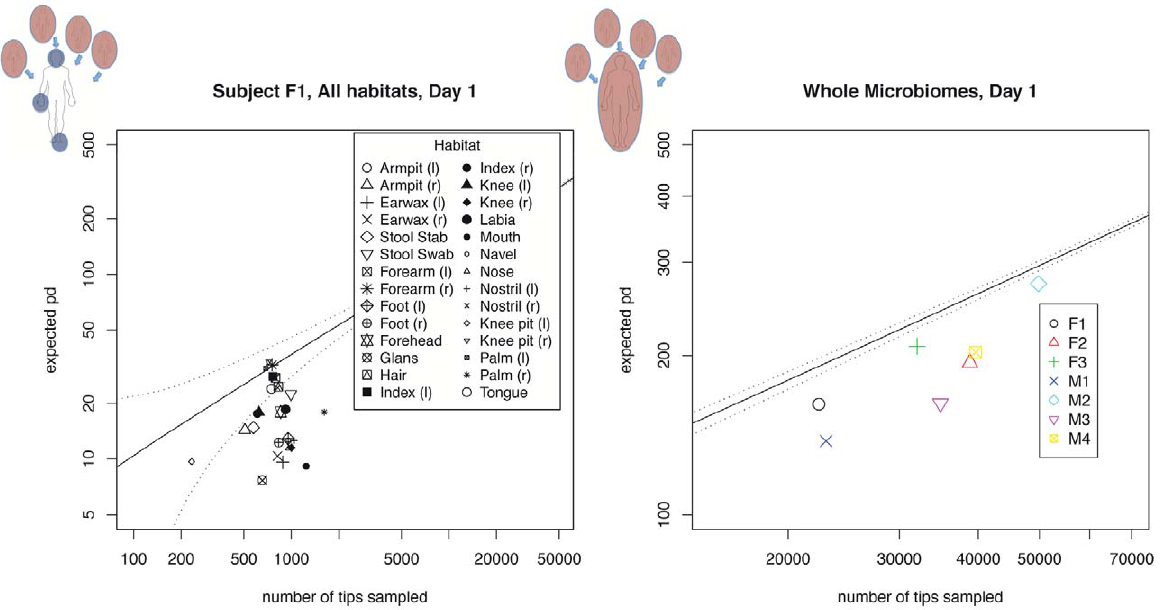
Figure 7. Increasing local community resolution reveals a diversity of clustered and overdispersed local samples. We show a comparison of actual PD with expected PD for multiple habitats and subjects. The lefthand panel shows the PD of all habitats sampled from subject F1, with the solid line indicating the expected phylogenetic diversity of a random sample from a metacommunity comprising all reads taken from all subjects, and the dotted line representing an upper bound on the corresponding 95% confidence interval. The right hand panel shows the total branch length for all reads sampled from each subject (again including F1 in black), with solid and dotted lines as on the left hand-side. When local samples are grouped into a single community for each microbiome, all microbiome communities are consistent with clustered sampling. On the other hand, we observe a wide range of variation in habitat PD relative to random sampling. corresponding to appropriately-sized random samples from the gut metacommunity.